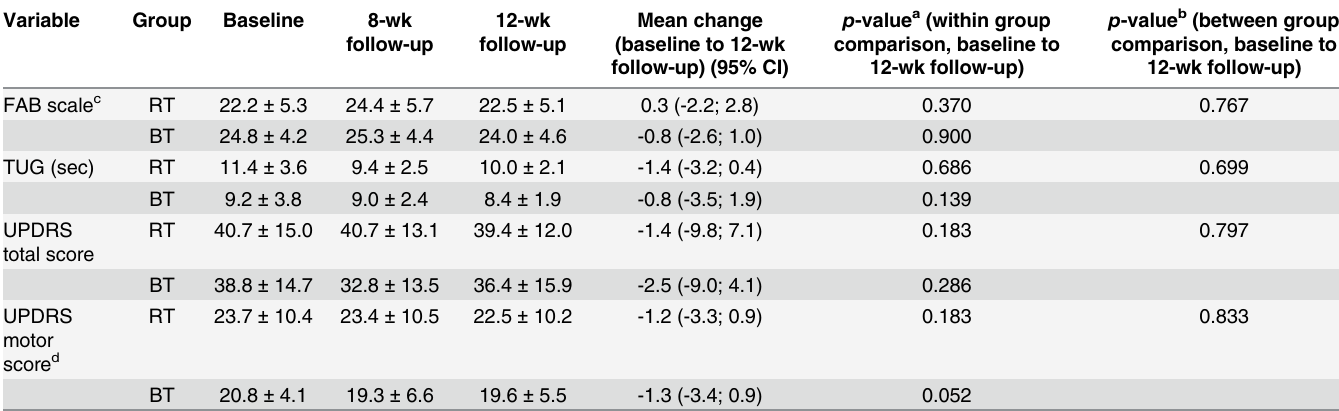
Table 3. Comparison of baseline, 8- and 12-weeks follow-up. Variable Group 8-wk